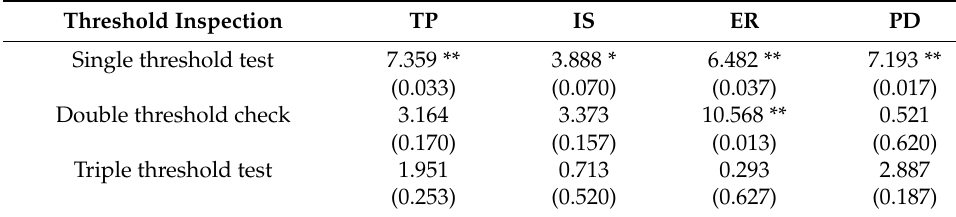
Table 6. Test on threshold effects.